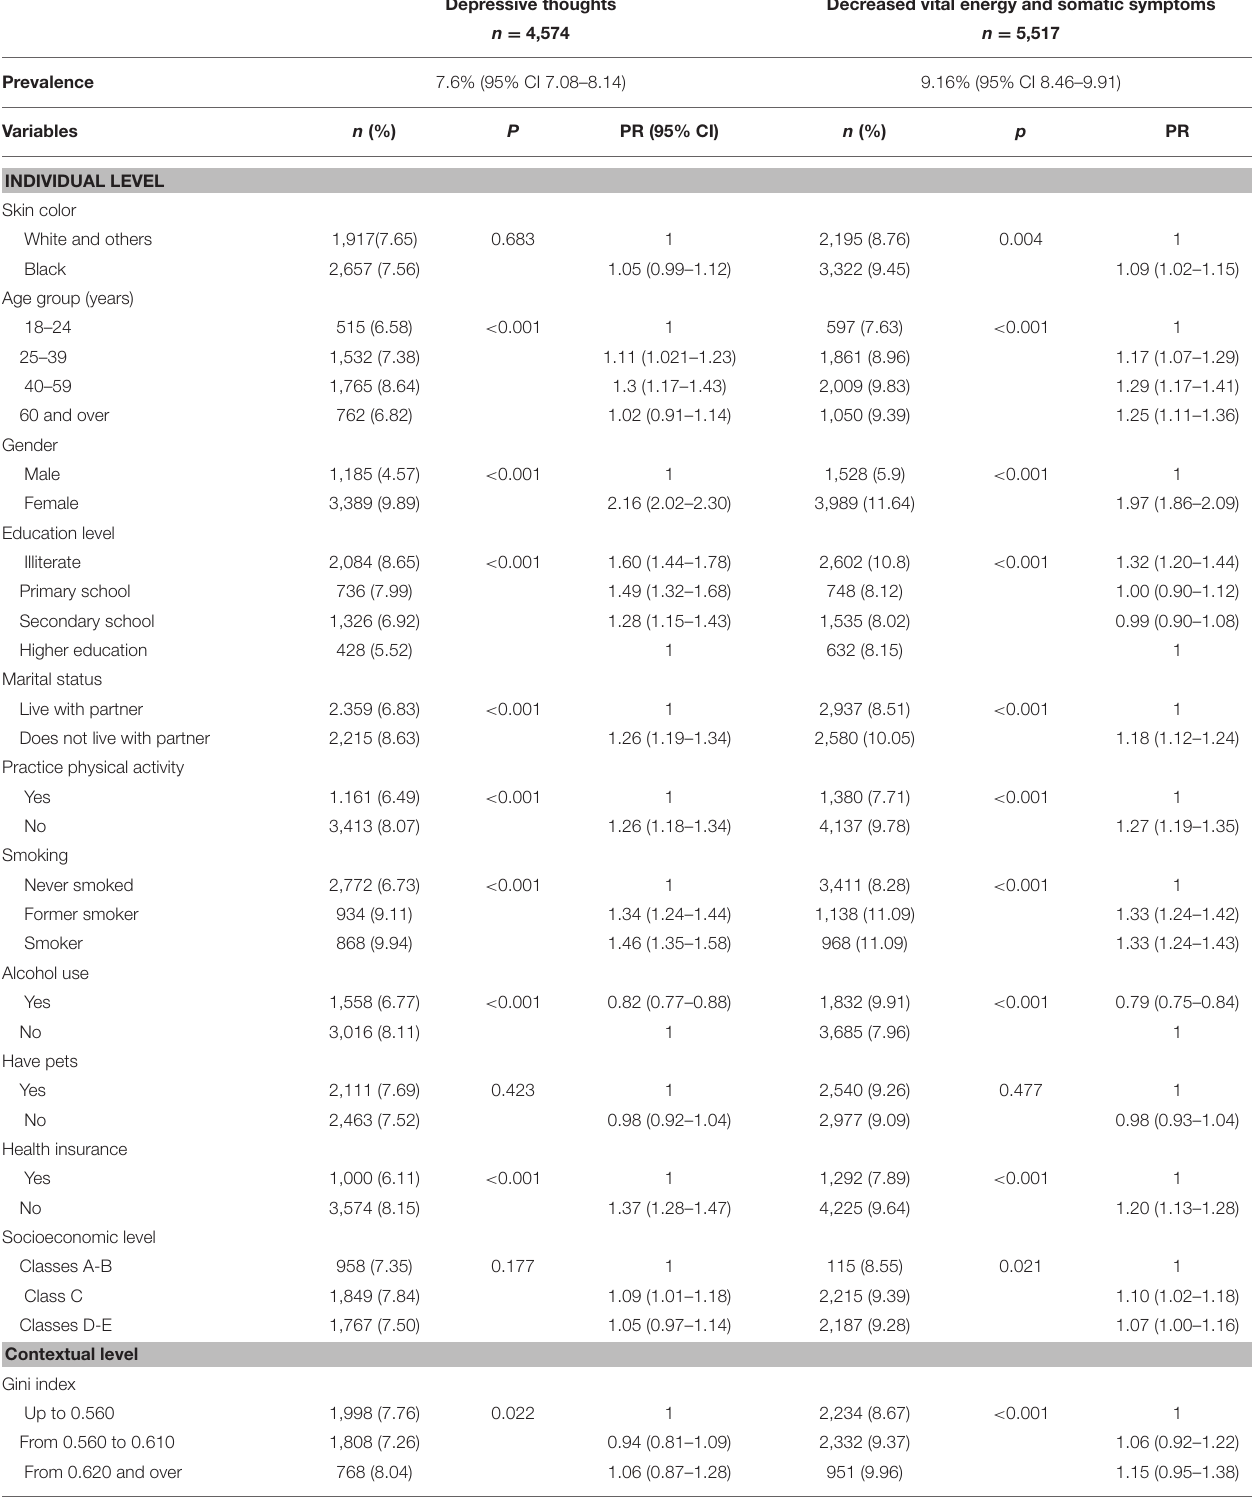
TABLE 2 | Bivariate association between outcomes and independent variables according to the 2013 Brazilian National Health Survey. Depressive thoughts Decreased vital energy and somatic symptoms n = 4,574 n =